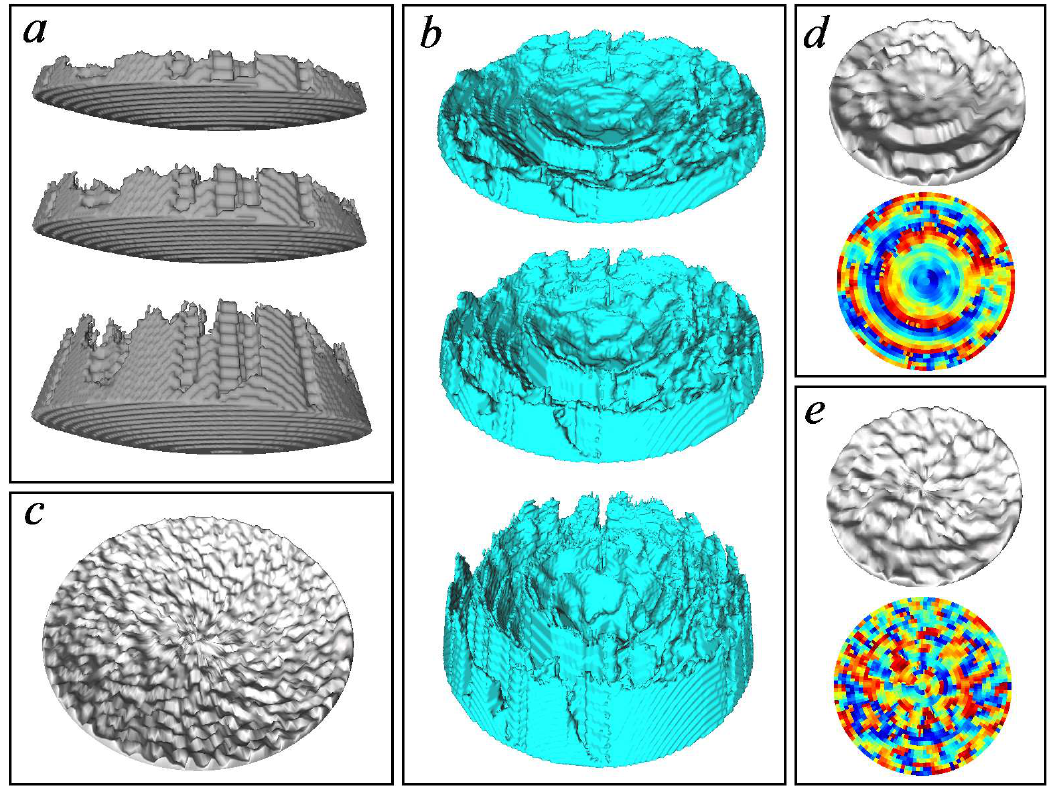
Figure 4. Representation of the Cartesian model of the lenses implemented in the simulations at points P1 ( a ) and P2 ( b ), with respective thicknesses of 10, 18, and 40 voxels. Images ( c – e ) represent the 10-voxel thick polar lenses associated respectively with points P3 ( c ) P2( d ) and P1( e ).